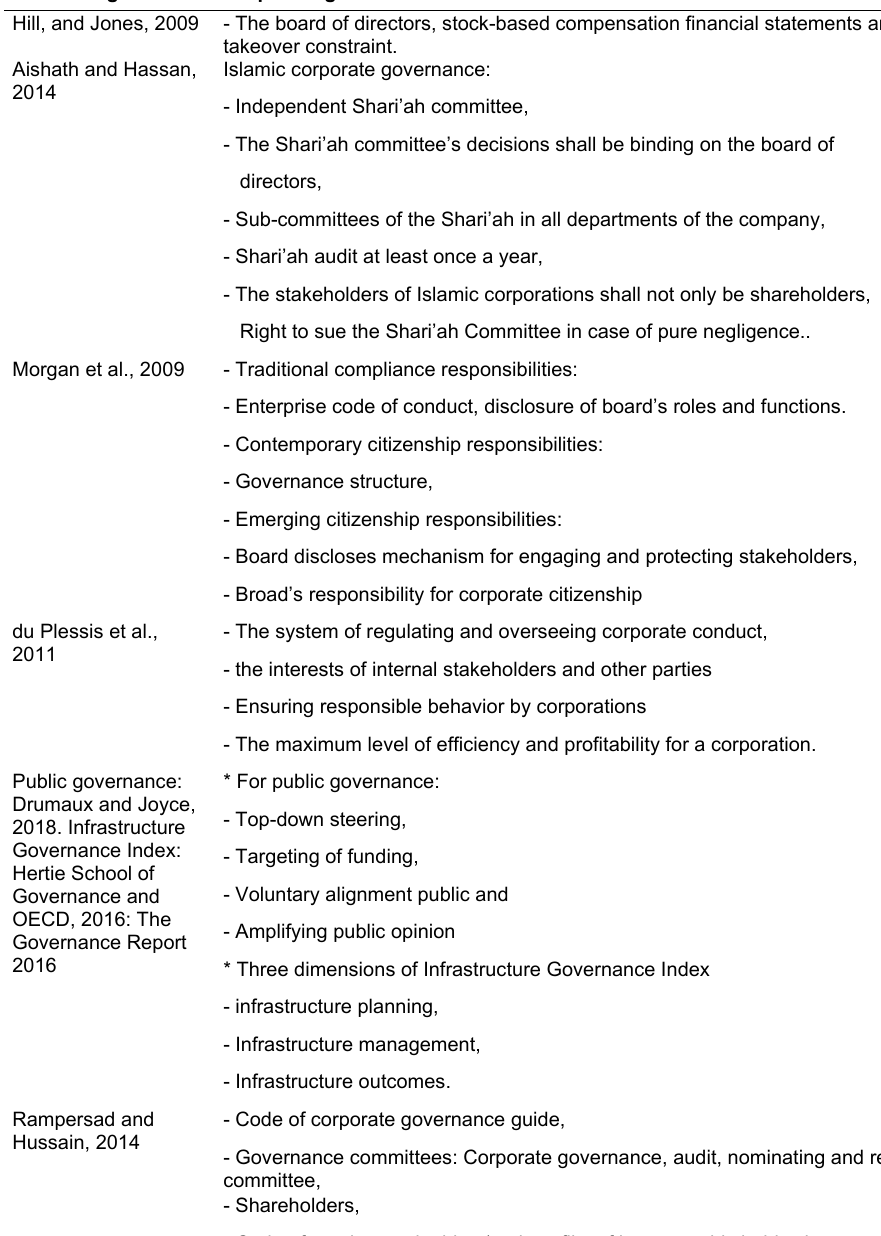
*Table 2. Corporate governance